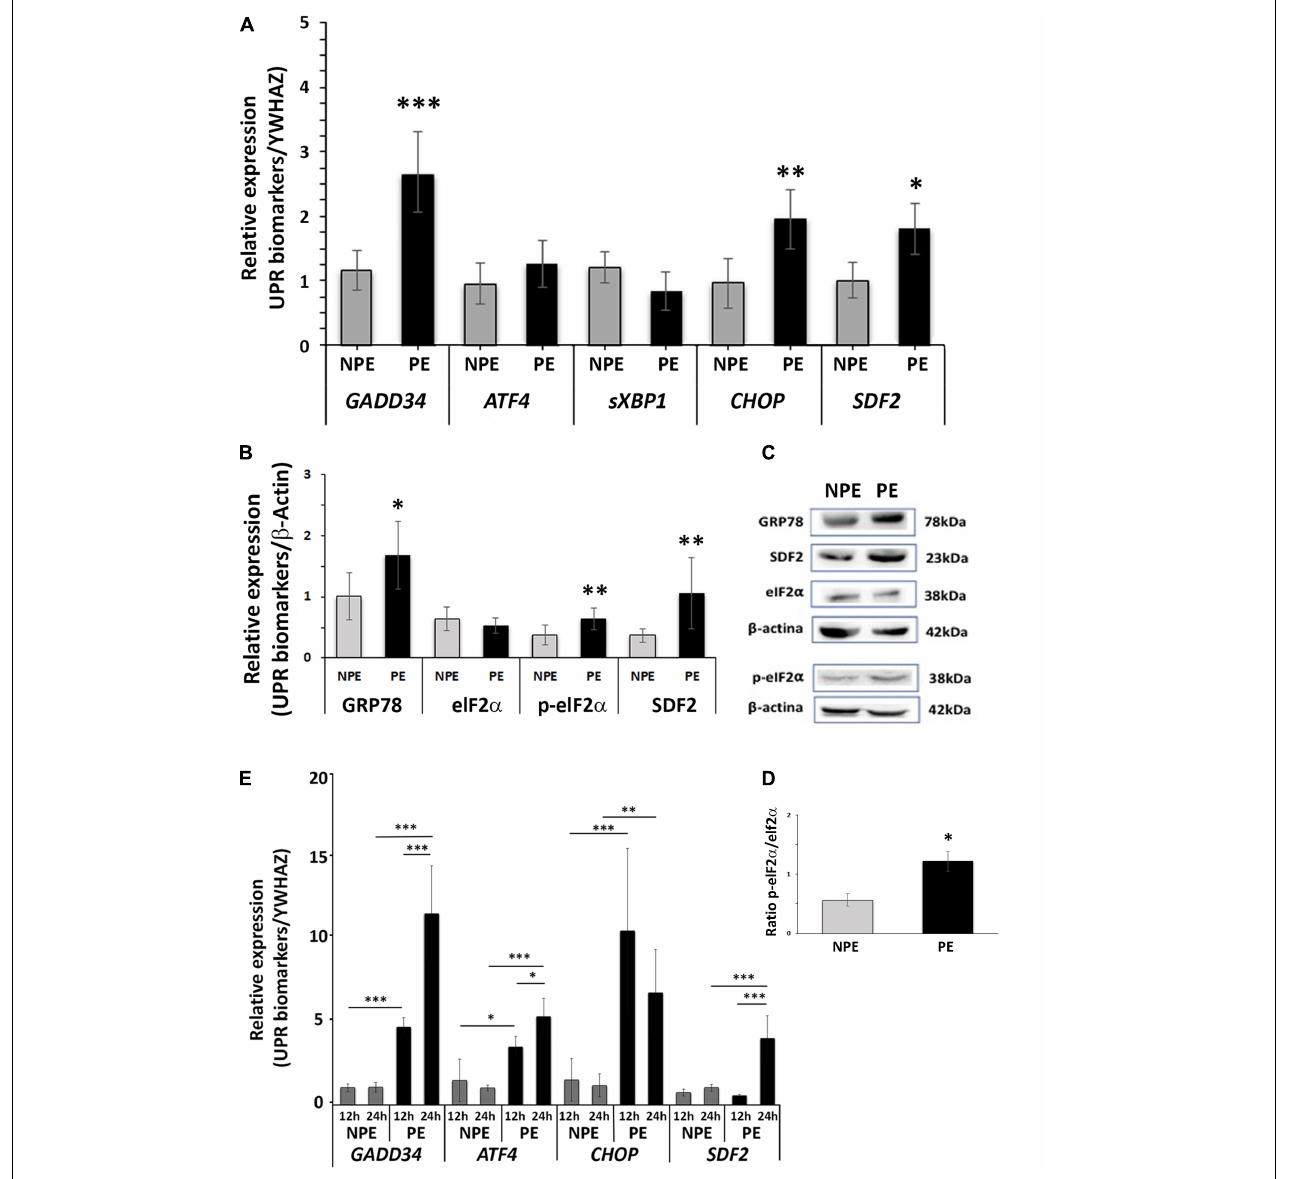
FIGURE 1 | Gene expression (A) and protein (B–D) analysis of placental explants (24-h-cultures) and gene expression of HTR8/SV-neo cells ( E: 12 and 24-h-cultures) cultured with PE serum (PE, black bars) and with serum from non-preeclamptic pregnant women (NPE, white bars). (A) GADD34 , CHOP , and SDF2 showed higher levels in comparison to respective controls. (B) The explants of PE serum-treated showed higher expression of GRP78 , p-eIF2 α , and SDF2 than the respective controls. The values were normalized to β -actin. (C) GRP78, SDF2, eIF2 α , p-eIF2a, and β -actin representative blots from placental explants. (D) Increased ratio p-eIF2 alpha: Total eIF2 alpha is seen in samples from PE-treated explants. (E) PE serum increased the gene expression of GADD34, CHOP, and SDF2 in HTR8/SV-neo cells. The data are represented as mean ± SD ( n = 7). Data from (A–D) were analyzed using the unpaired Student’s t -test followed by the Mann-Whitney posttest. Times of the HTR8/SV-neo cultures were analyzed using analysis of variance and Tukey’s multiple comparisons post hoc test. ∗ p < 0.05, ∗∗ p < 0.005, ∗∗∗ p <